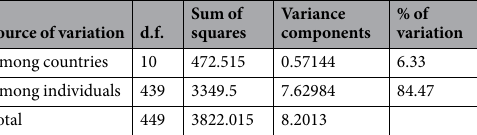
Table 1. Analysis of molecular variance (AMOVA) for tea individuals from all the 11 countries.